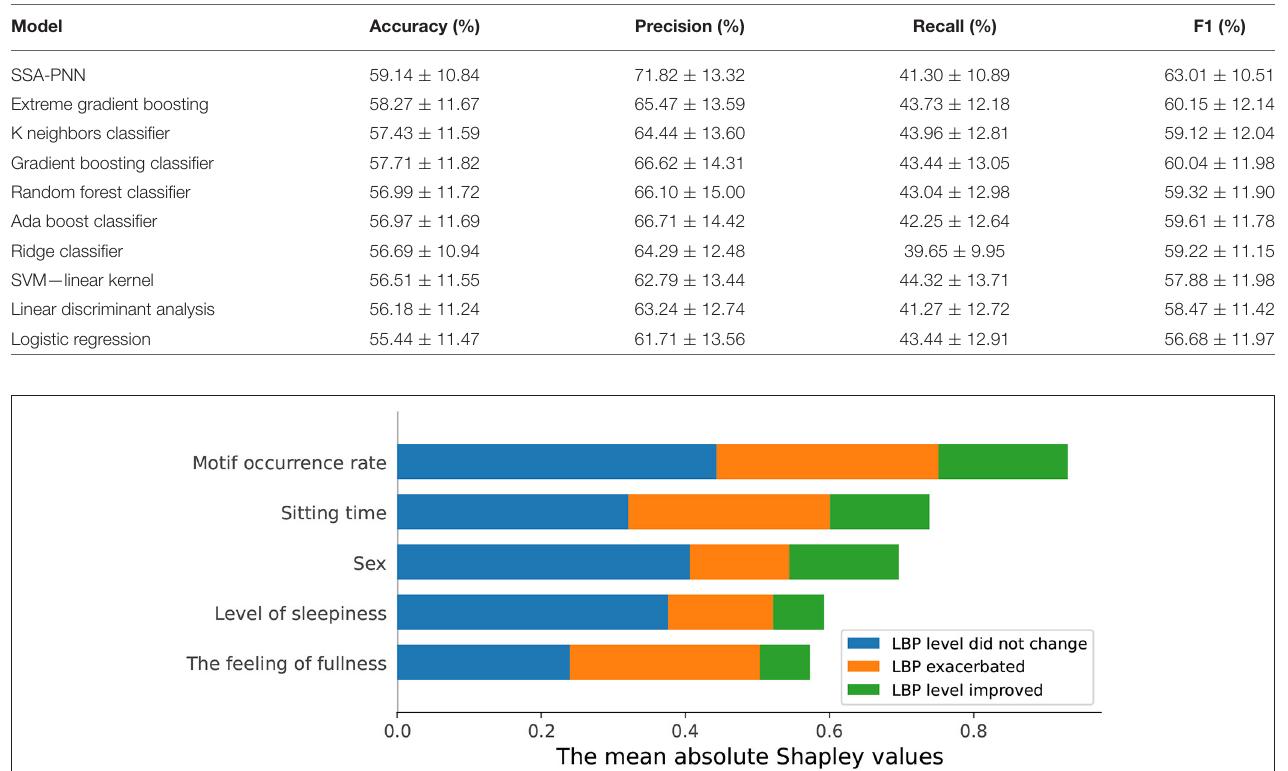
TABLE 5 | Model performance comparison with fixed hyperparameters.